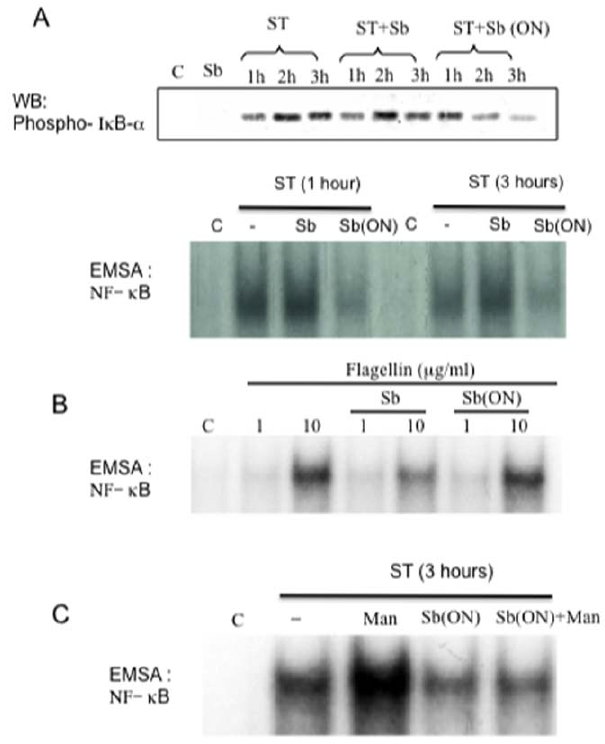
Figure 10. S.boulardii influences on S. Typhimurium-induced I k B- a phosphorylation and NF- k B signaling pathway. (A) Samples were resolved by SDS-PAGE and analyzed by immunoblotting with anti-phospho-I k B antibodies. Determination of NF- k B binding activity was analyzed by EMSA. (B) S. boulardii did not decrease NF- k B binding activity induced by 1 or 10 m g/ml of flagellin. (C) S. boulardii induced decrease of NF- k B binding activity is not modified in the presence of a -D-mannose. Western blots and EMSA shown are representative of 5 independent experiments.